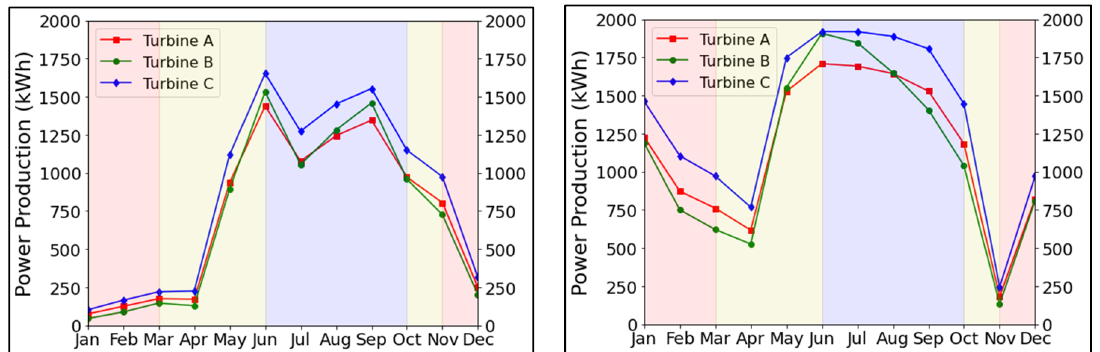
Figure 8. Monthly average power production estimated using the power curve of three selected wind turbines in Banyuwangi ( left ) and Wetar Island ( right ) (2015 data). The red-colored region indicates the rainy season, blue indicates the dry season, and yellow indicates the transition seasons between the dry and rainy season and vice versa.